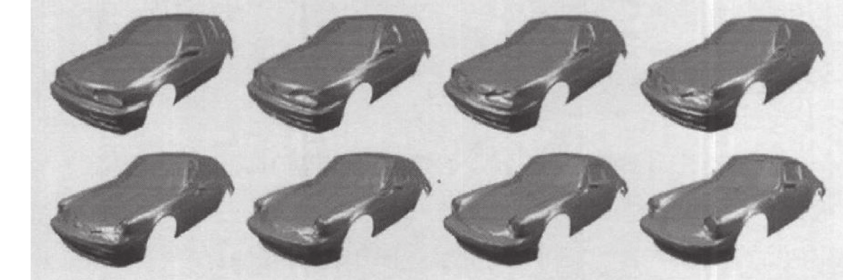
Figure 1: Contour fusion between a Volkswagen and a Porsche.